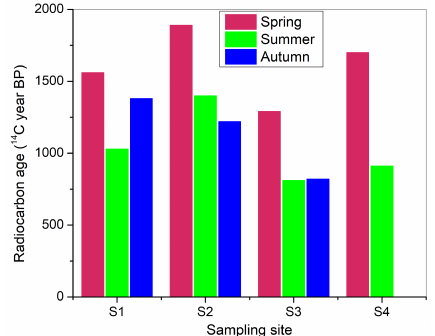
Figure 5. Seasonal variations in radiocarbon age ( 14 C years BP) of the emitted CO 2 from the Wuding River